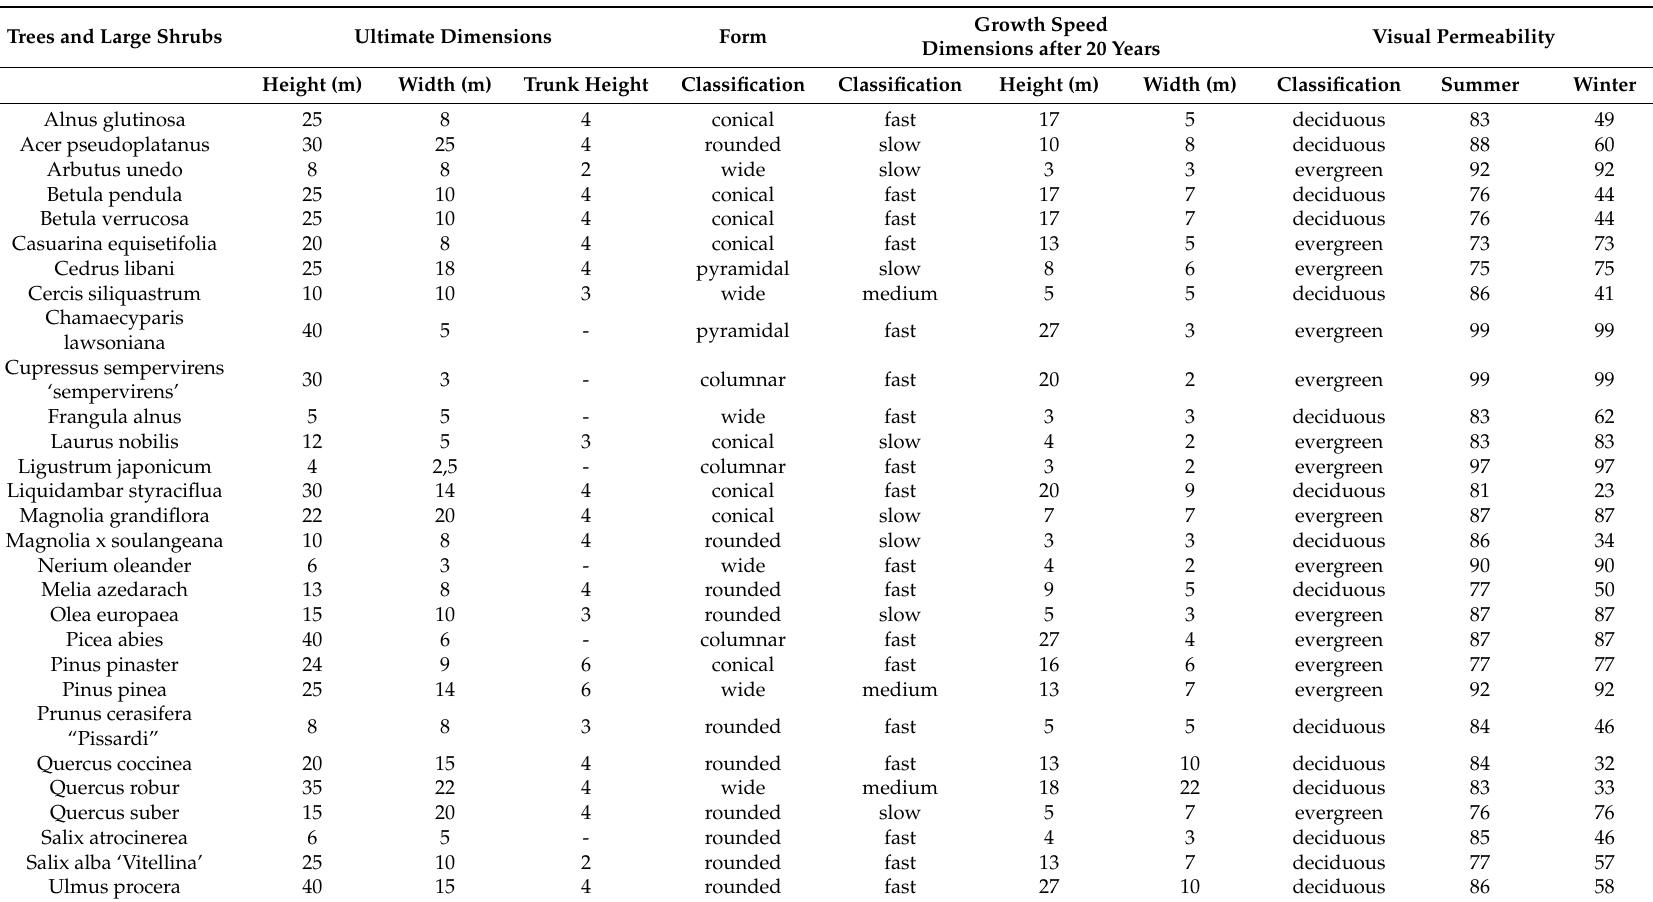
Table 1. Classification of trees present in the case study considering: (1) Dimensions (m) at maturity age; (2) Form; (3) Growth Speed and dimensions (m) after 20 years of development; (4) Visual permeability of the crown [17] (p.